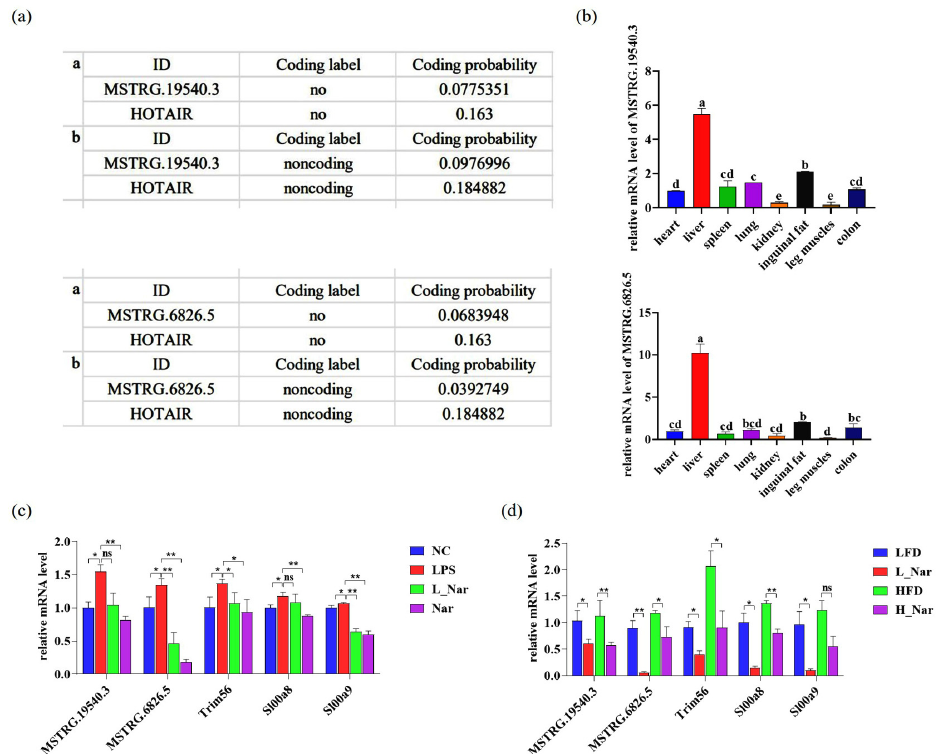
Figure 6. Effect of Nar on lncRNAs and their target genes in AML ‐ 12 cells and diet ‐ induced obese mice: ( a ) protein coding ability prediction: a is the CPAT result, b is the CPC result; ( b ) tissue expression profile; ( c ) real ‐ time PCR detection of lncRNAs and related target genes mRNA expression in AML ‐ 12 cells and ( d ) diet ‐ induced obese mice. Data are expressed as mean ± SEM (n = 3). * p < 0.05, ** p < 0.01; Bar graphs with the same superscript letters indicate no significant differences ( p > 0.05), while with different superscript letters indicate significant differences ( p < 0.05) .